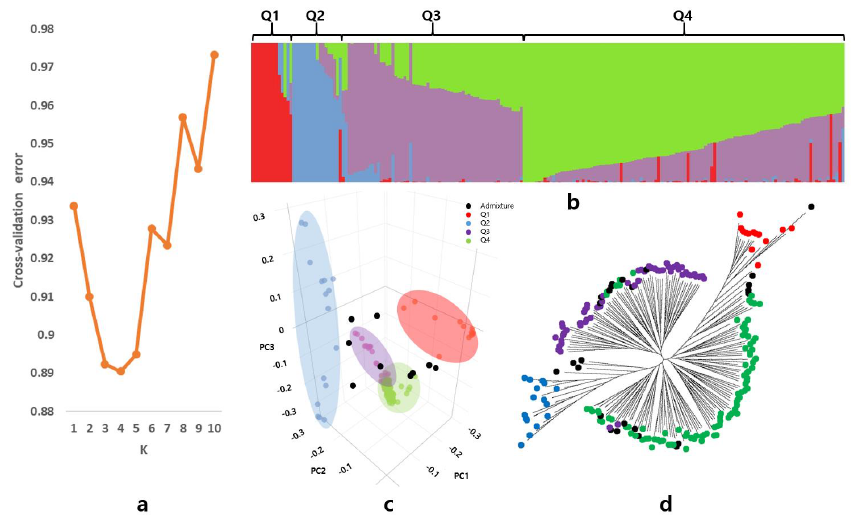
Figure 3. ( a ) Cross-validation error for the assumed number of populations ( K ) in ADMIXTURE analysis. ( b ) Classification of 203 wild soybean accessions into four sub-populations using ADMIXTURE. The colors red, blue, purple, and green represent separate groups with different levels of admixture. ( c ) Scatter diagram for the principal component analysis of 203 accessions calculated using PLINK, with each colored spot representative of one cluster of Q 1 to Q 4. ( d ) Neighbor-joining cluster analysis in MEGA11, with each colored spot representative of one cluster of Q 1 to Q 4.